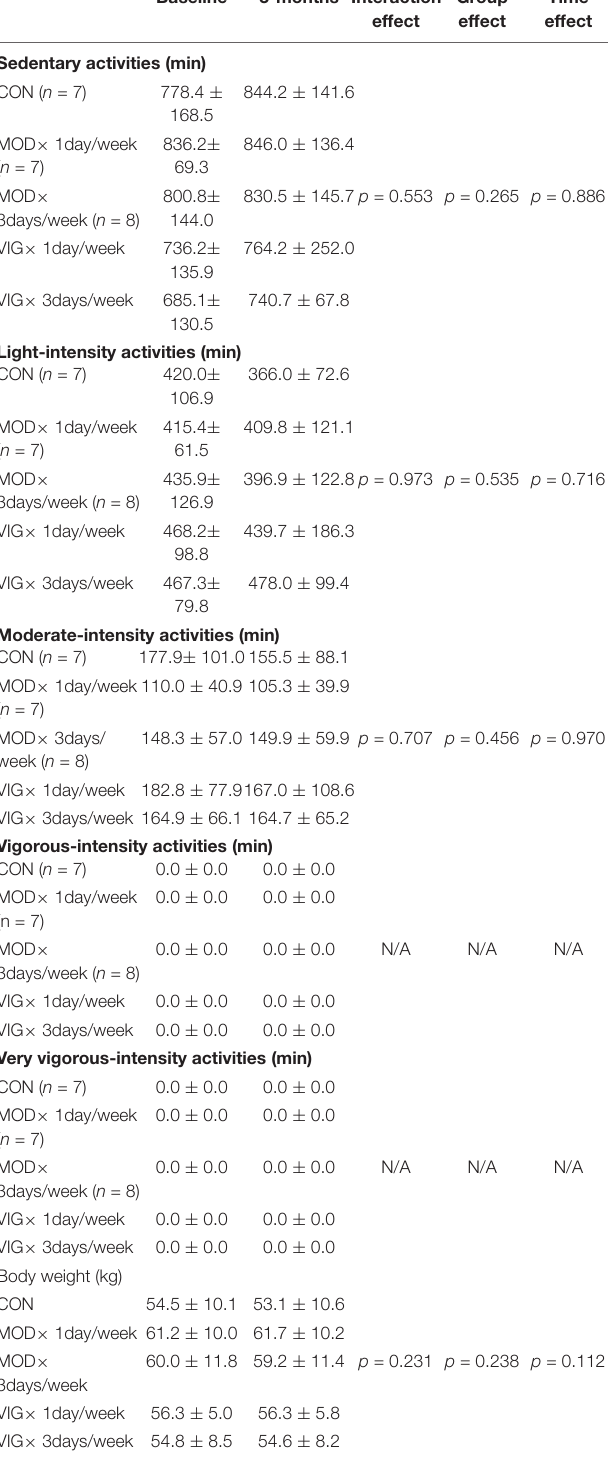
TABLE 3 | Summary of the habitual physical activities and body